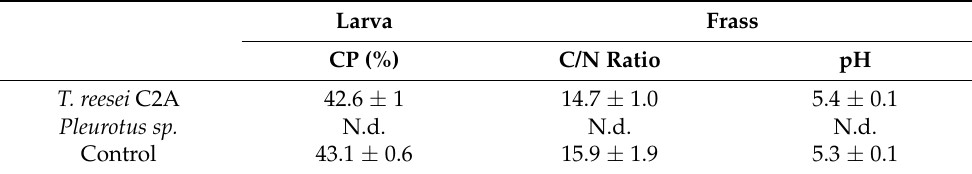
Table 1. Chemical properties of larvae and frass from H. illucens ( n = 4, mean ± SD). Larva Frass CP (%) C/N Ratio Pleurotus sp.